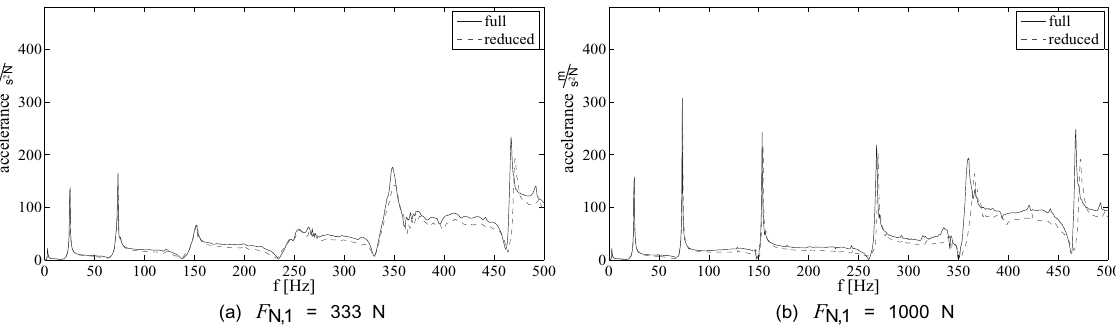
Fig. 6. FRFs for impulse excitation with method A for different normal forces (note the linear scale).